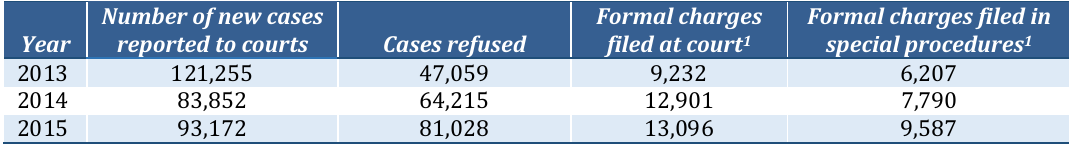
Table 6: Cases refused and formal charges filed at entrance courts in capital cities and El Alto, 2013